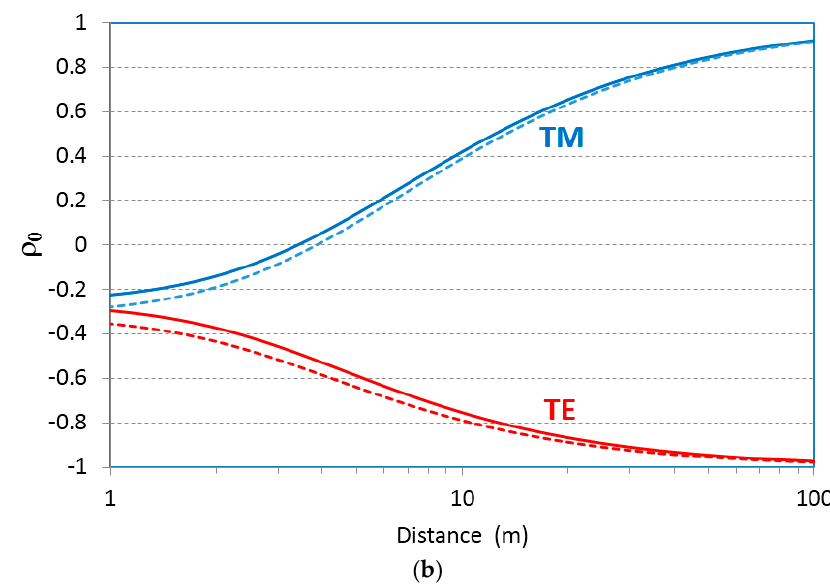
Figure 2. Soil reflectivity as a function of distance between the transmitter and receiver ( a ) when h t = h r = 10 cm; and ( b ) when h t = h r = 1 cm at frequency 94 GHz. Solid line—little moisture. Dashed line—moist soil.